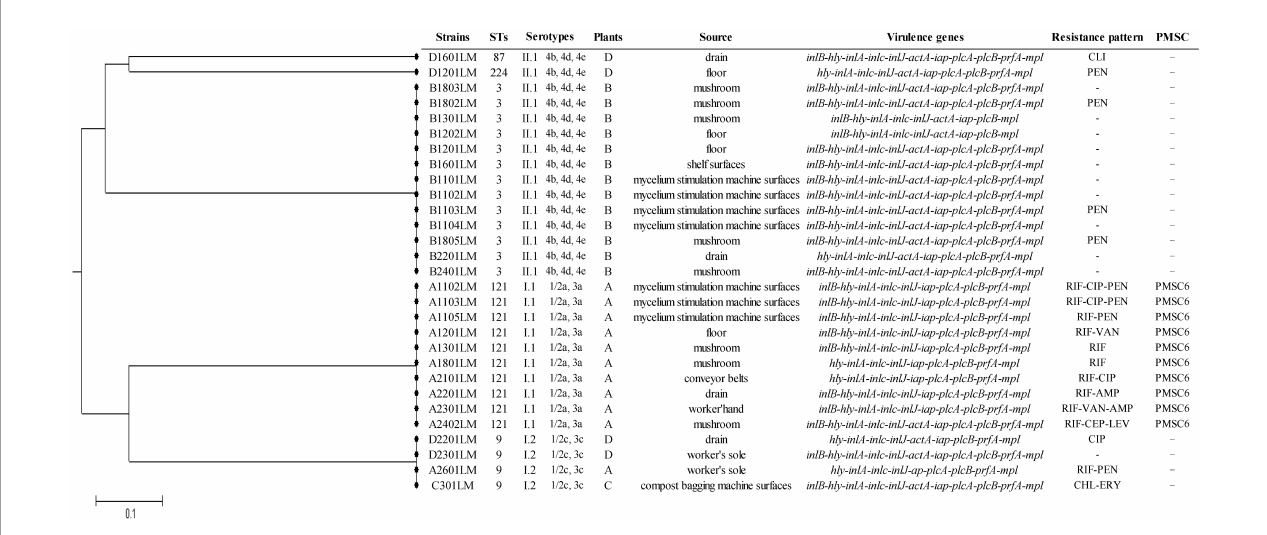
FIGURE1 The unweighted pair group method with arithmetic mean (UPGMA) tree of the seven multilocus sequence typing loci of L. monocytogenes isolates from Pleurotus eryngii production plants. This tree was generated using the S.T.A.R.T (version